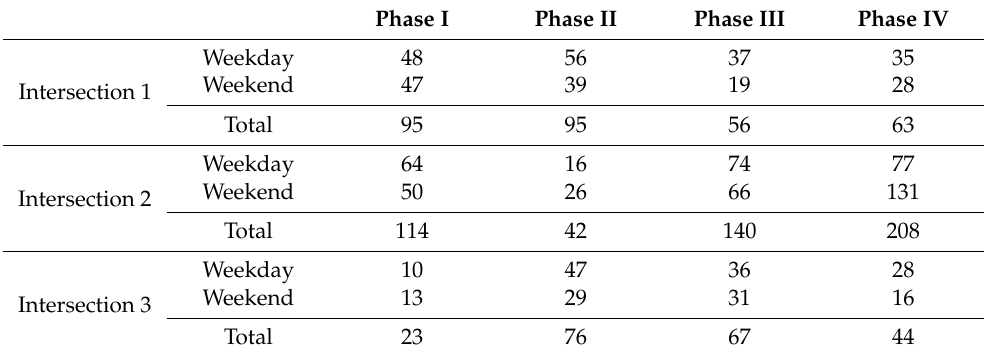
Table 6. Frequencies of horn use during each green light phase for all measured time periods.